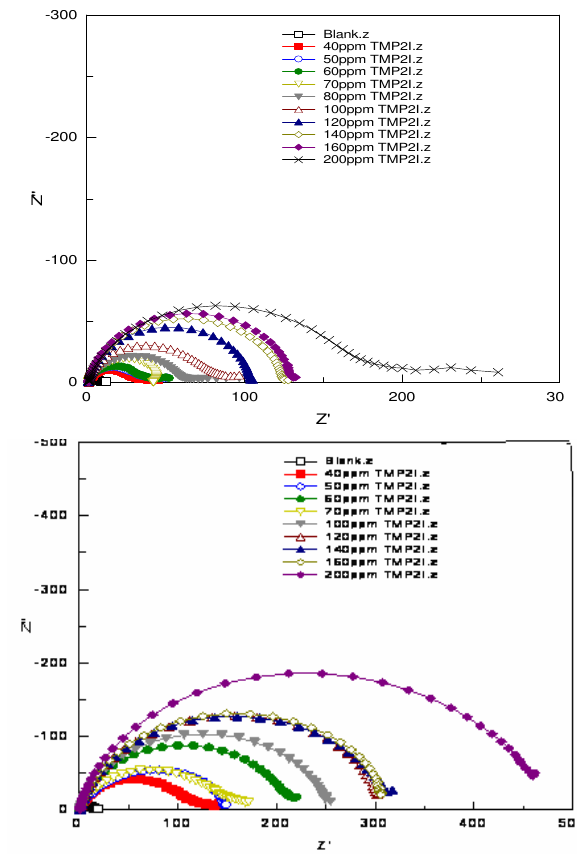
Figure 5. Impedance diagram of mild steel in the presence of TMP2I in acid media The impedance parameters like Rct, Rp, Cdl and IE are presented in Table 3. The results also show that Rct values increased with increase in increase concentration of the inhibitor. The percentage inhibition calculated form Rct values indicated that TMP2I acts as good inhibitor in both acid media. The Cdl values found to decrease with increase in concentration of inhibitor solutions. This behaviour is generally seen for system where inhibition occurred due to the formation of a layer by the adsorption of inhibitor on the metal surface. The decrease in Cdl value suggest that the inhibitor molecule act by adsorption at the metal solution interface 26